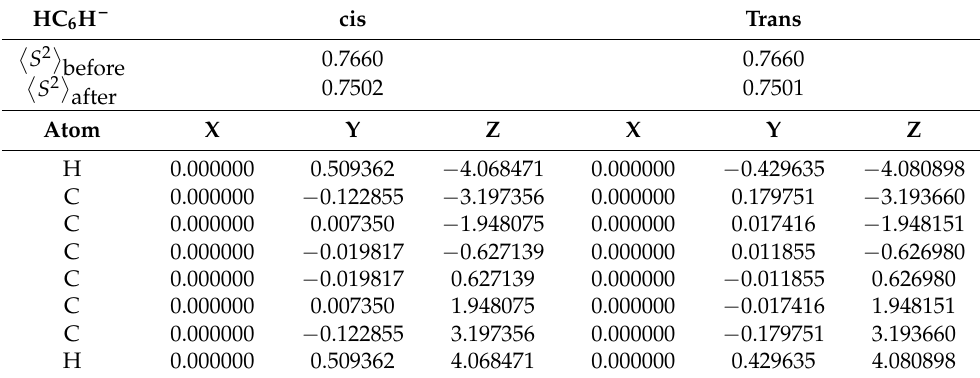
Table A4. Cartesian coordinates in Å of the cis and trans HC 6 H – anion conformers optimized at the